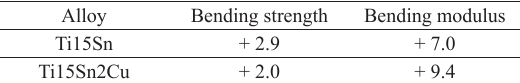
Table 2. The relative ratios (%) of bending strength and bending modulus of AS versus HT of Ti15Sn x Cu. Alloy